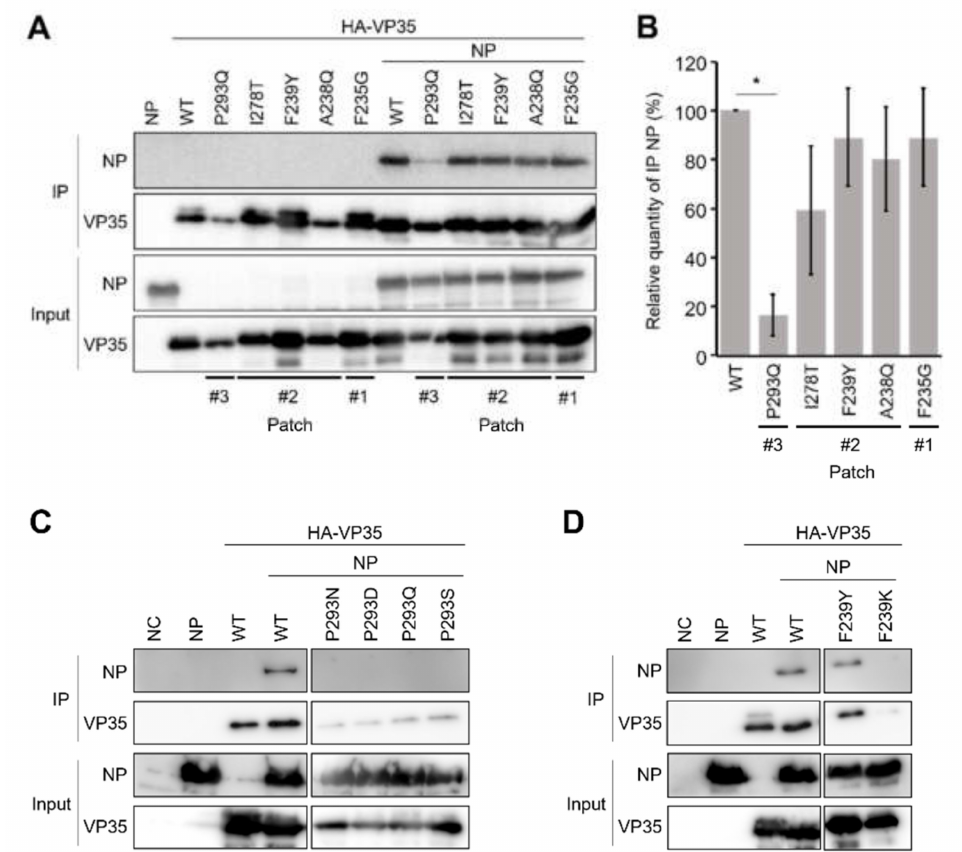
Figure 3. NP-VP35 interaction attenuated by hydrophobic patch modifications in VP35 IID. ( A , C , D ) Representative western blot images of EBOV NP immunoprecipitated from HEK293T cells trans- fected with the plasmids expressing EBOV NP and with wild-type VP35 (WT) or VP35 mutants. Representative mutants for patches #1, #2, and #3 ( A ), patch #3-disrupted mutants ( B ), and F239 mu- tants (patch #2) ( C ) were analyzed. Cells were lysed with a lysate buffer 36 h post-transfection. Then NP-bound HA-tagged VP35 was precipitated from samples using anti-HA affinity gel beads and analyzed by Western blotting. ( B ) Band intensities of immunoprecipitated NP relative to VP35 are quantified by western blotting. Each bar represents mean ± SE from three independent experiments. Dunnett’s multiple-comparison test was used to compare to WT (* p <